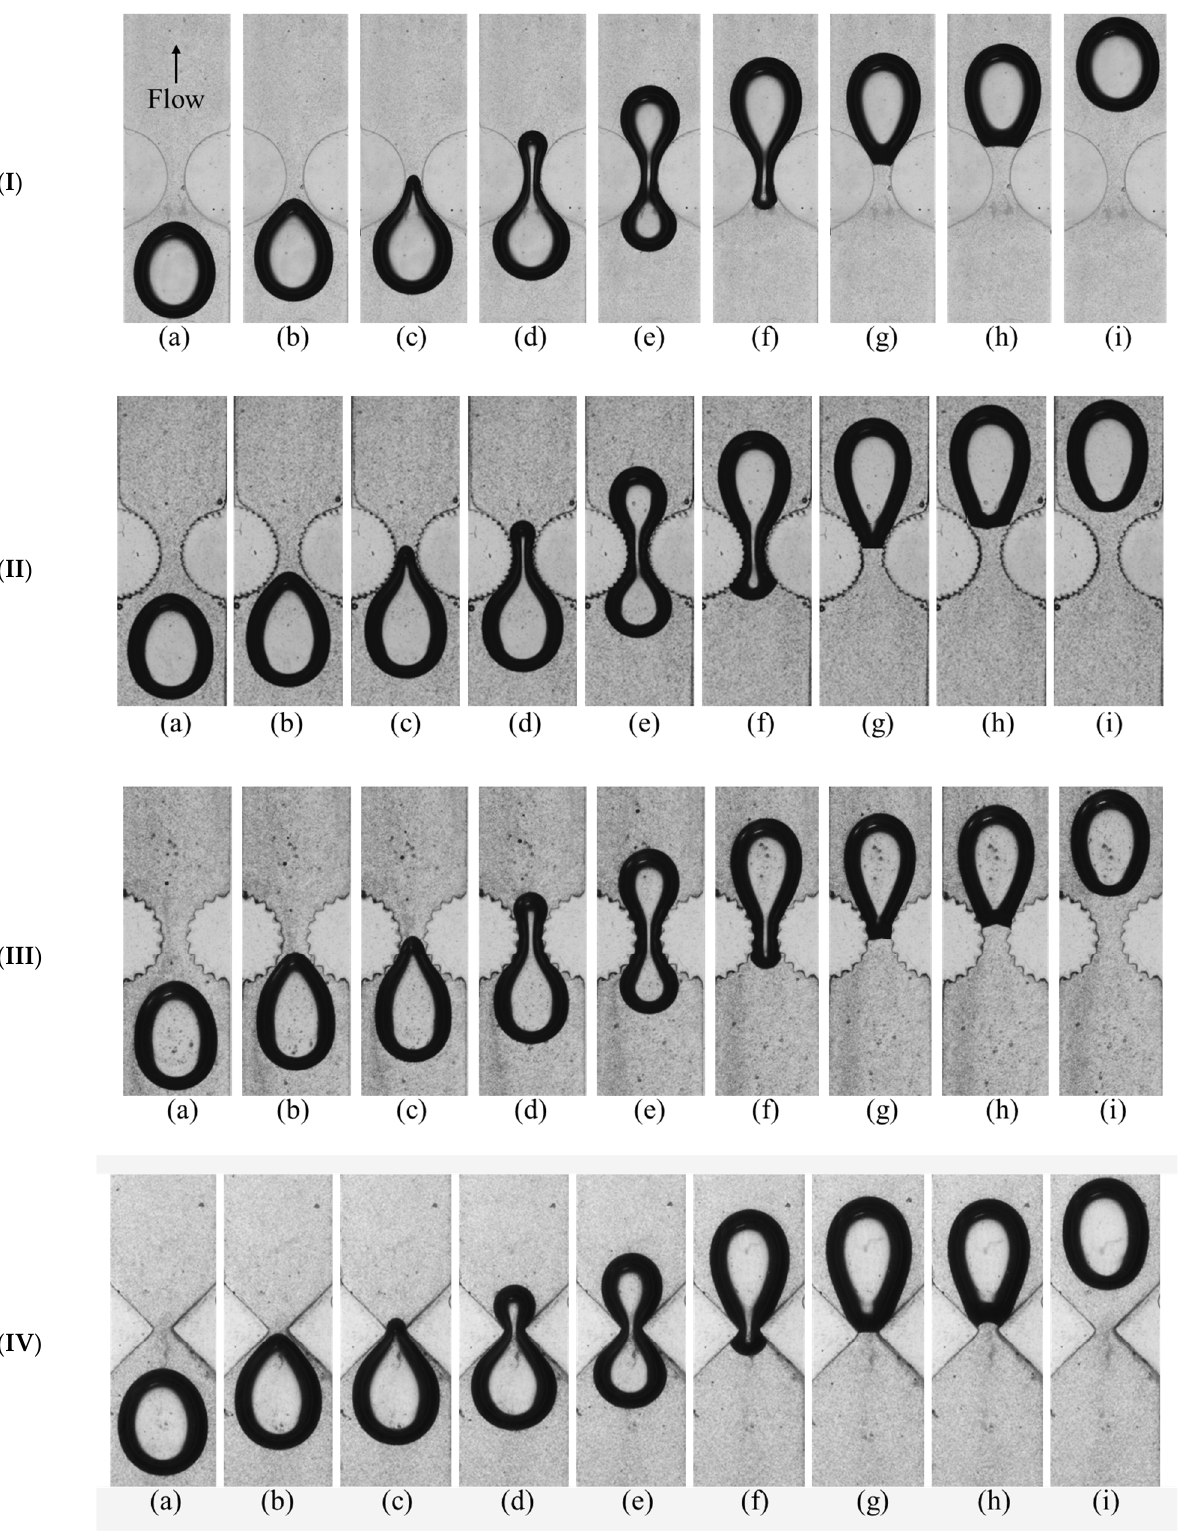
Figure 6. Bubble passing through ( I ) circular pore ( II ) circular pore with 0.2 mm surface roughness, ( III ) circular pore with 0.4 mm surface roughness, and ( IV ) pore with a sharp corner.